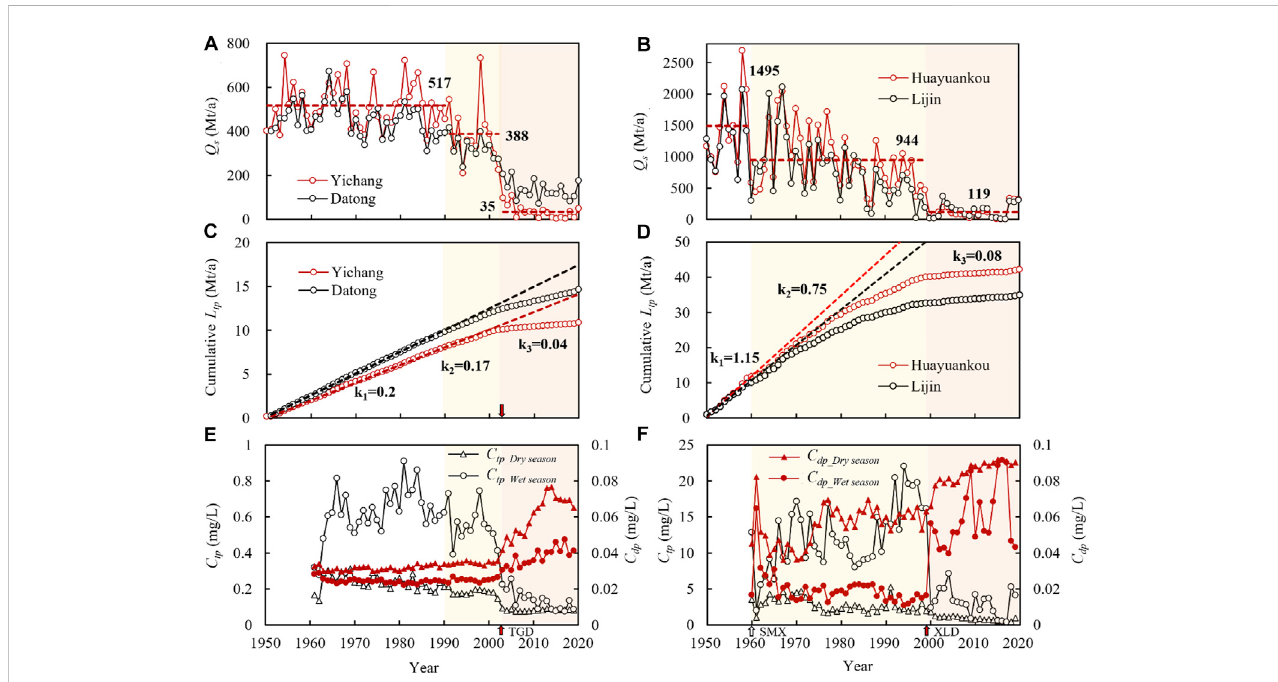
FIGURE 7 Long-term variation in the annual sediment load ( Q s ) and accumulative total P fl ux ( L tp ) at Yichang and Datong in the Yangtze River (A and C) , and at Huayuankou and Lijin in the Yellow River (B and D) (1950 – 2020). Long-term variation of the simulated total P concentration ( C tp ) and dissolved P concentration( C dp )atYichangintheYangtzeRiver (E) andatHuayuankouintheYellowRiver (F) duringthedryseason(October – MayintheYangtzeRiverand November – JuneintheYellowRiver)andthewetseason(June – SeptemberintheYangtzeRiverandJuly – OctoberintheYellowRiver)(1960 – 2019).The dashed lines indicate the average value of the corresponding process at Yichang (A) and Huayuankou (B) , and the slope of the cumulative L tp at Yichang and Datong (1951 – 1990) (C) , and at Huayuankou and Lijin (1950 – 1959) (D) . k 1 ~k 3 denotes the average growth rate of L tp in 1951 – 1990, 1991 – 2002,